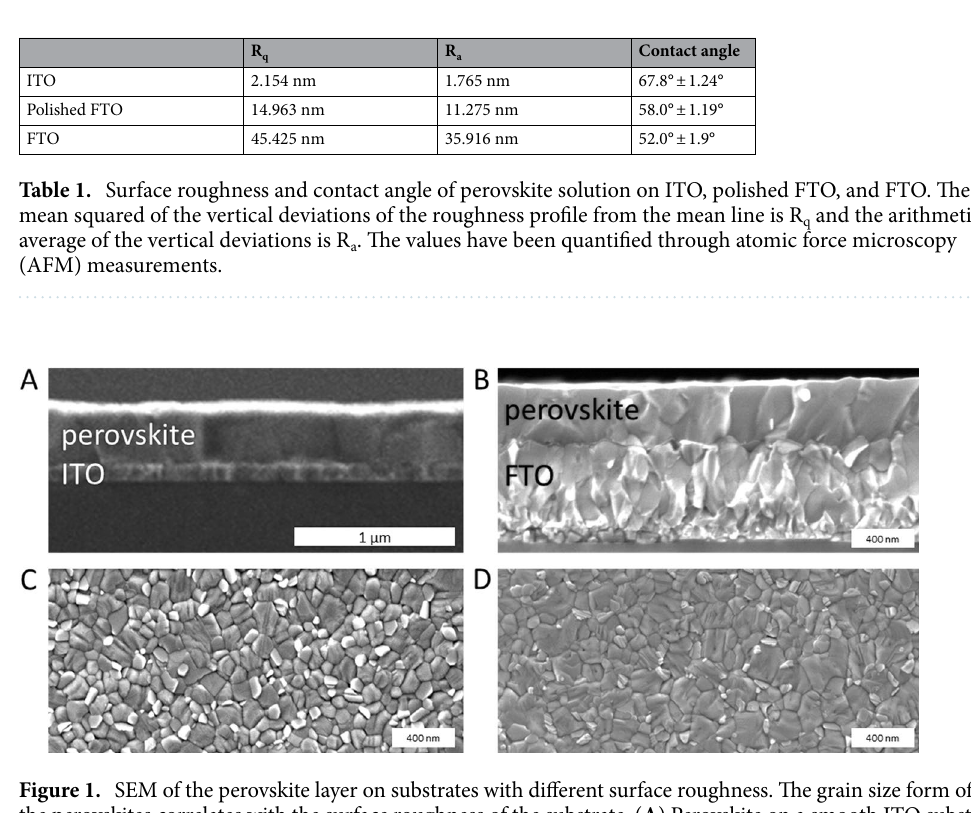
Figure 1. SEM of the perovskite layer on substrates with different surface roughness. The grain size form of the perovskites correlates with the surface roughness of the substrate. ( A ) Perovskite on a smooth ITO substrate showing relative straight grains. ( B ) Perovskite on SnO 2 /FTO, the roughest substrate, with ca. 48 nm surface roughness showing less orientation orthogonal to the substrate. ( C ) Top-view SEM image of perovskites layers on ITO and on ( D ) FTO. Voids between crystals are more clearly pronounced on the ITO